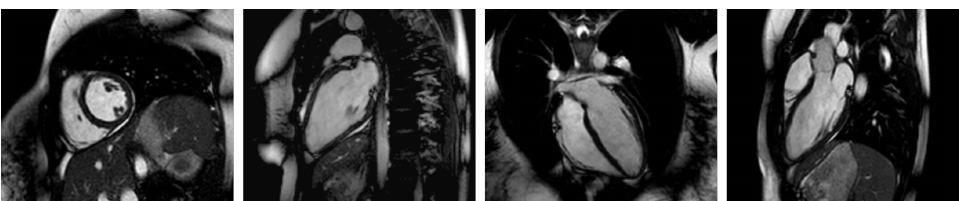
Figure A2. Short-axis cine image and long-axis cine images of healthy subject without left ventricu- lar hypertrophy.